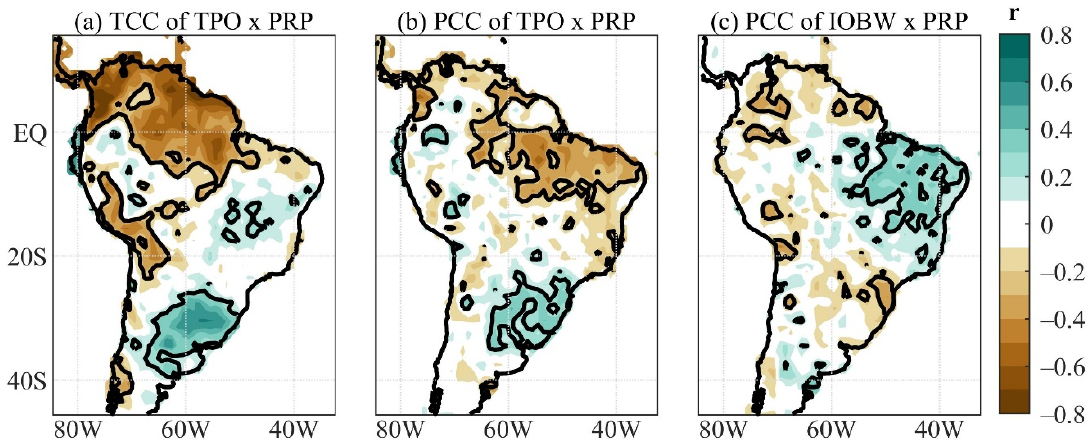
Figure 5. Latitude vertical cross ‐ sections of the partial correlations for the vertical velocity in pressure coordinate aver ‐ aged in the 60° W ‒ 35° W band (VVEL) during southern summer: ( a ) TPO and VVEL; ( b ) IOBW and VVEL. Graphical display is the same as that in Figure 4.